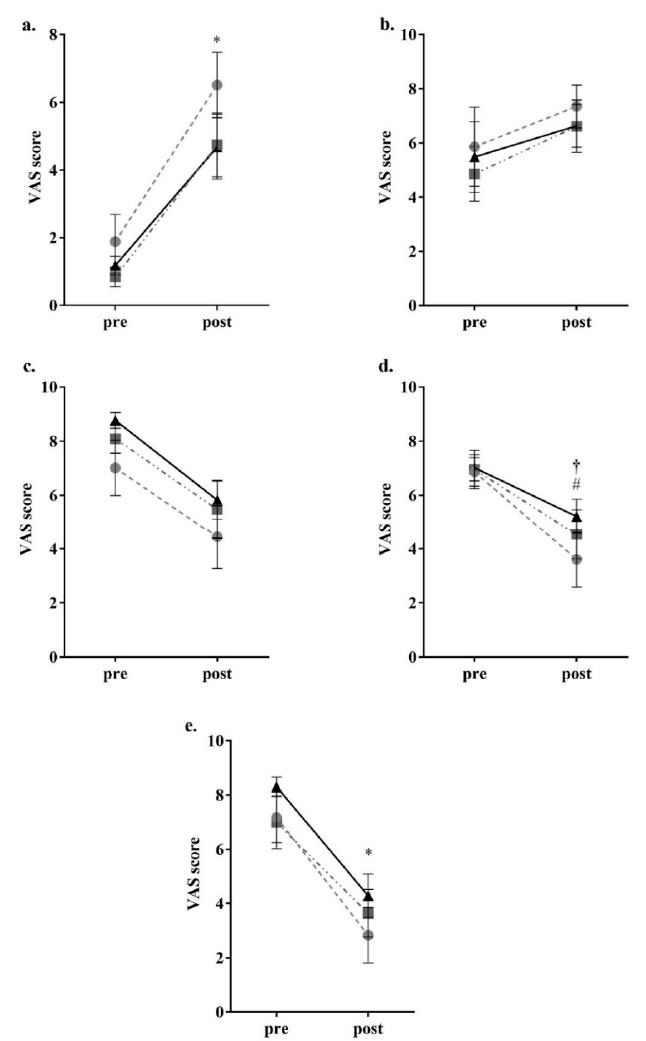
Figure 2. Participant visual analogue scale appetite parameter responses. ( a ) Fullness; ( b ) Satisfaction; ( c ) Desire to eat; ( d ) Prospective food intake; ( e )